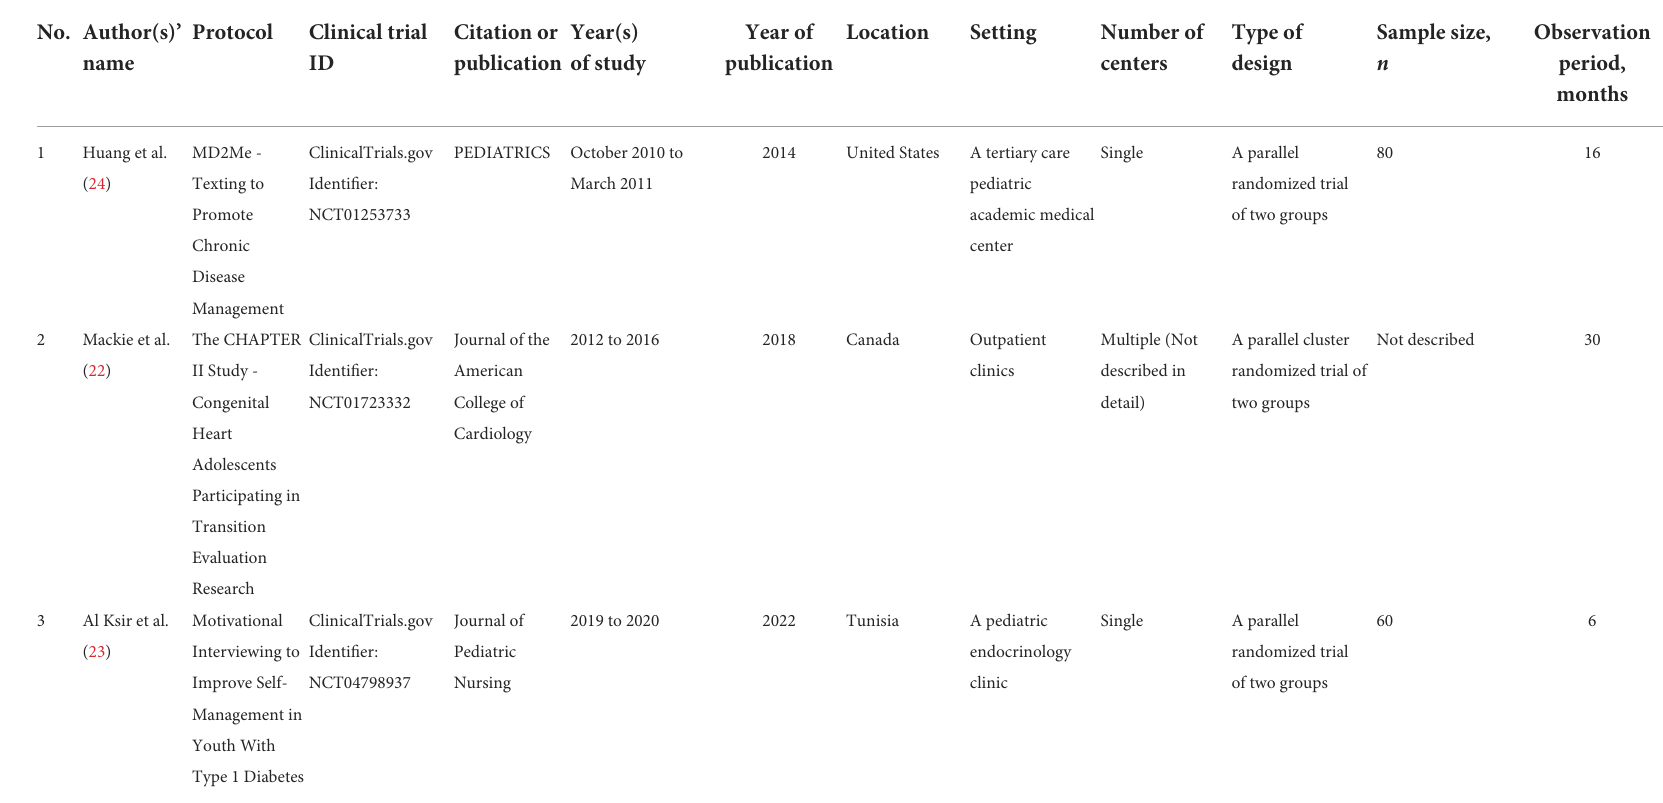
TABLE 1 Characteristics of